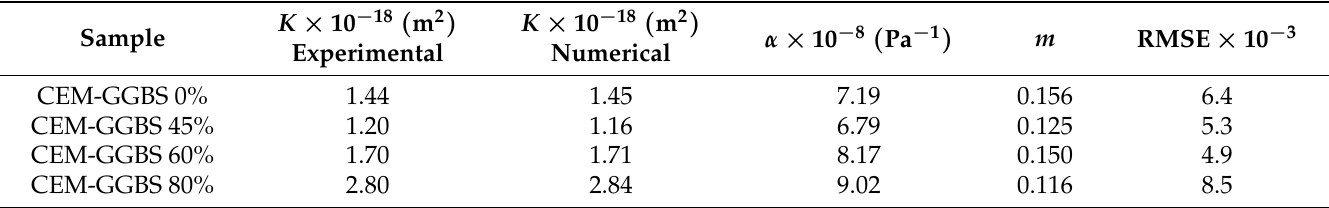
Table 3. Parameter values estimated using MCMC and the associated water inflow RMSEs of mortar samples subjected to standard curing